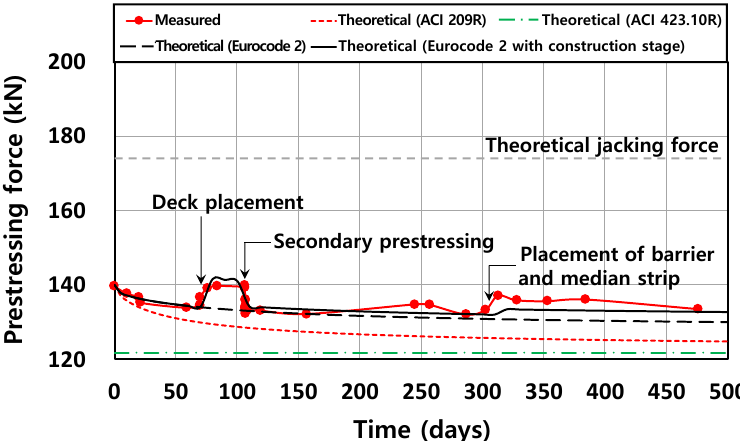
Figure 10. PFs at mid-span in the PSC girder bridge.